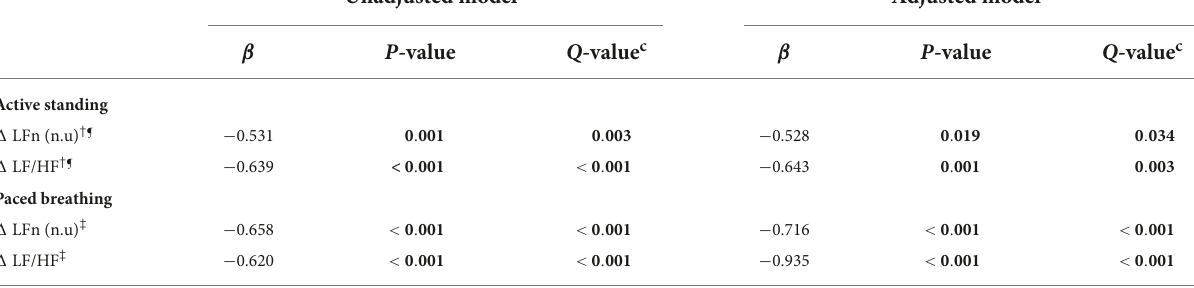
TABLE 4 HRV indices as predictors of cognitive change in subjects with MCI at baseline ( n =